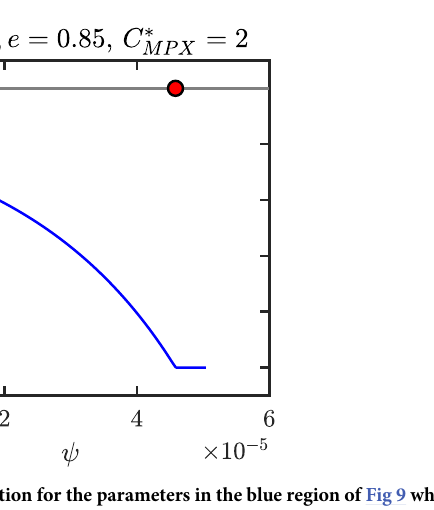
. Unless varied or otherwise specified, the parameters are HI